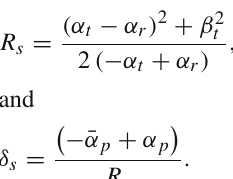
and θ = π with a = 0 . 4 , b = 0 . 5, and k = 0 . 2 4 6